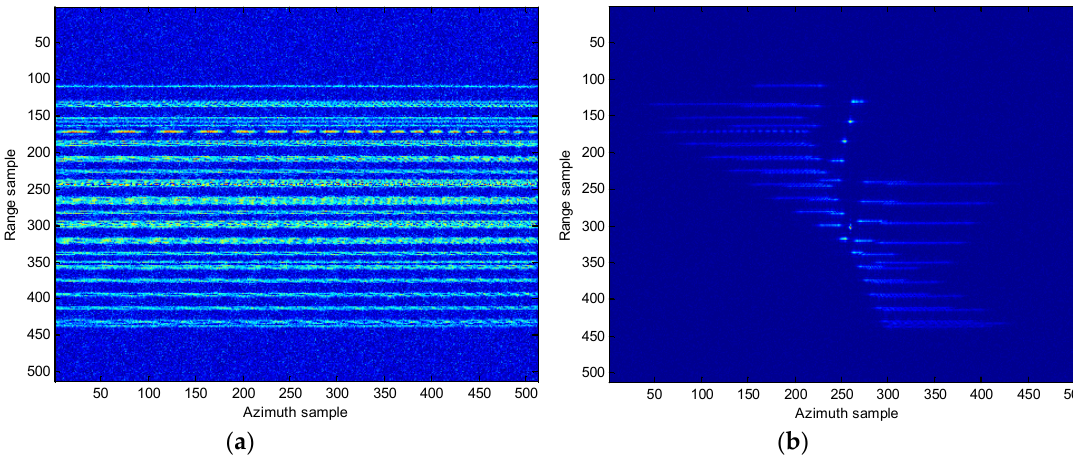
Figure 9. Range compression and imaging result with migration compensation. ( a ) Range compression; ( b ) RD imaging result.